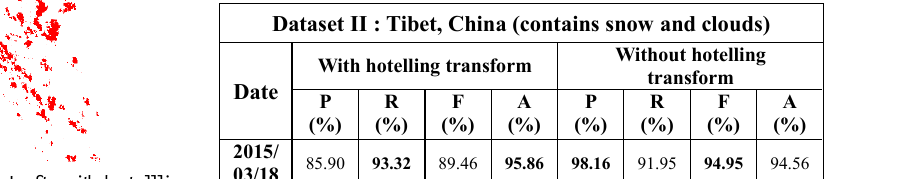
Figure 8 . Comparison results in dataset I. Left: with hotellling transform. Right: without hoteling transform.